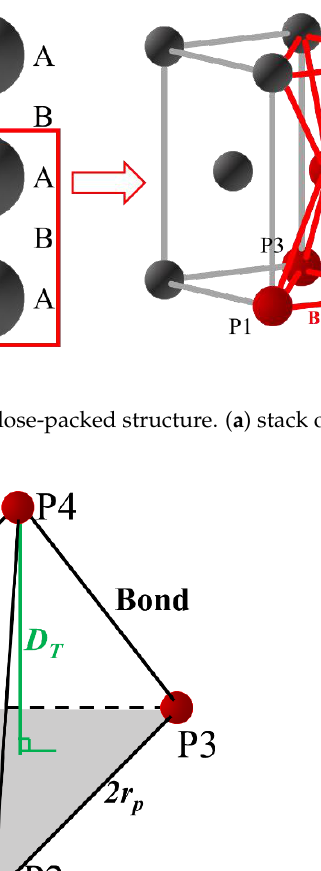
Figure 10. Hexagonal close-packed structure. ( a ) stack of particles in PFC 3D ( b ) simplified particle- bond model